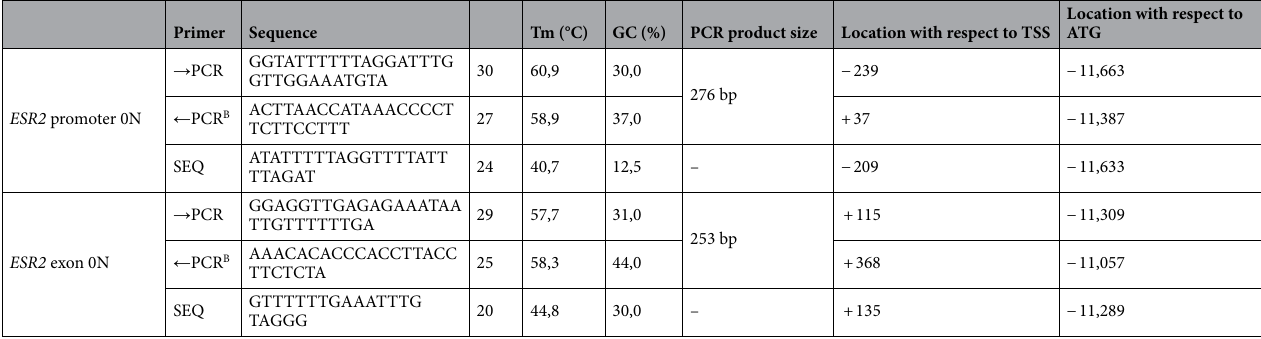
Table 1. Primer sequences and location. → PCR, forward primer; ← PCR, reverse primer; B , biotinylated primer; Tm, melting temperature, GC, guanine-cytosine content; bp, base pairs; TSS, transcription start site; ATG, start codon; SEQ, sequencing primer.